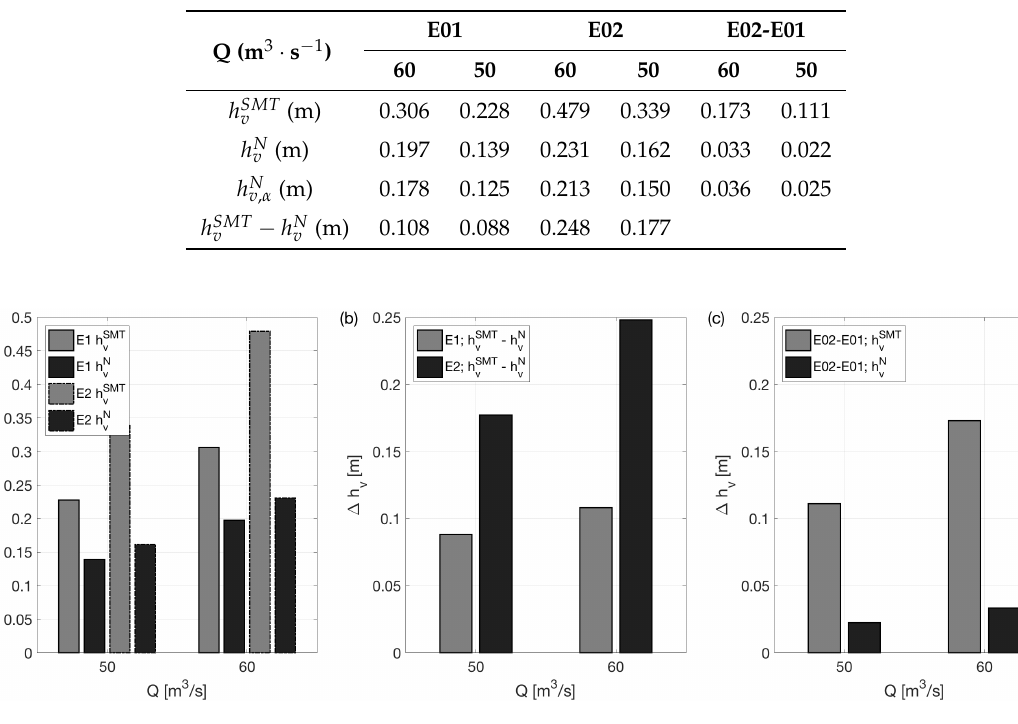
Figure 4. Visualisation of the results in Table 1—( a ) Comparison of the local head loss h v (m) of the scale model test (SMT) with a modified trash rack and the numerical simulation (N)—( b ) differences between SMT and N—( c ) differences between the two